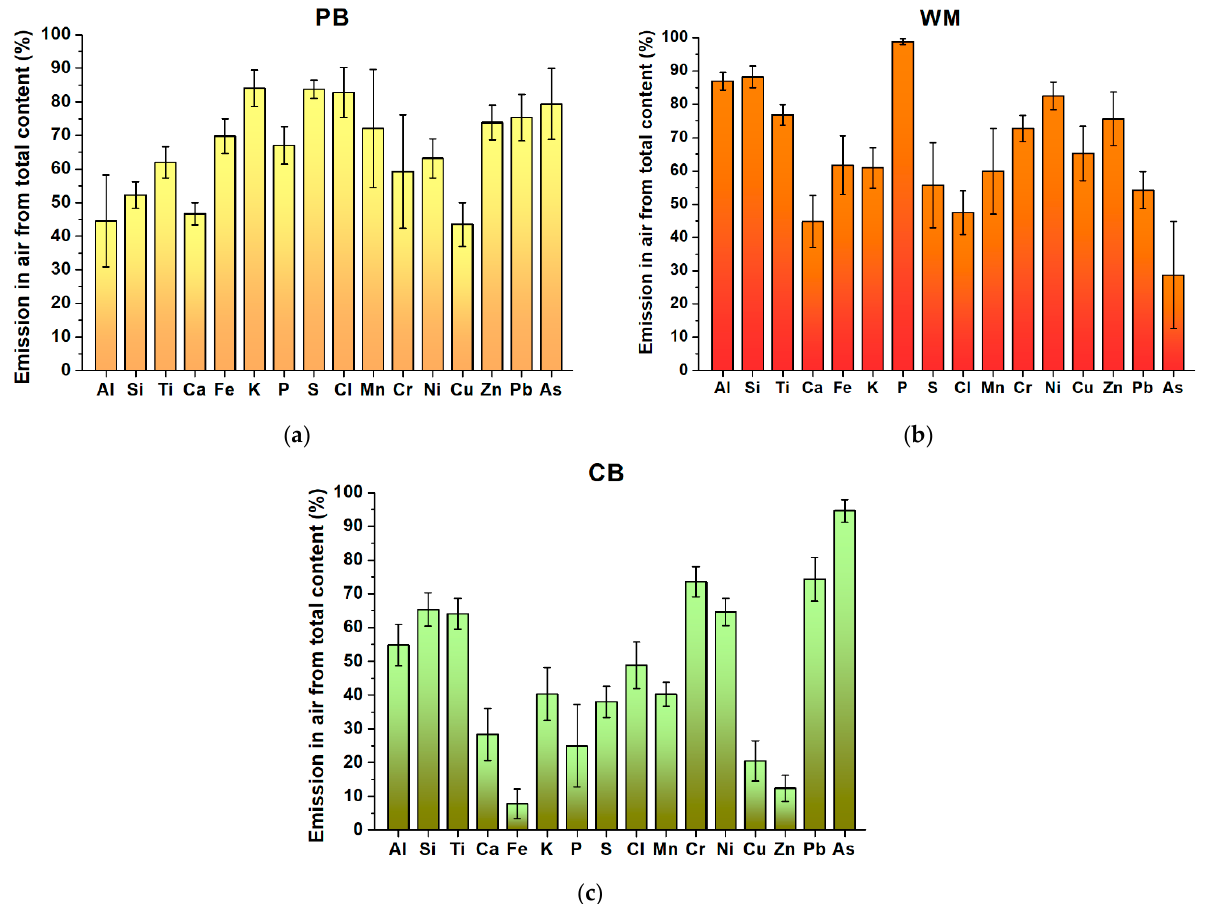
Figure 3. Amounts of elements emitted during combustion from the stack expressed as a proportion of the total amount of elements contained in the burnt fuel (calculated from the values for both BEC2 and BEC3)—( a ) paper briquettes PB, ( b ) briquettes from waste wood WM, ( c ) coal briquettes CB. Table 9. Relative differences in the amounts of the element released into the atmosphere resulting from a comparison between the combustion equipment.